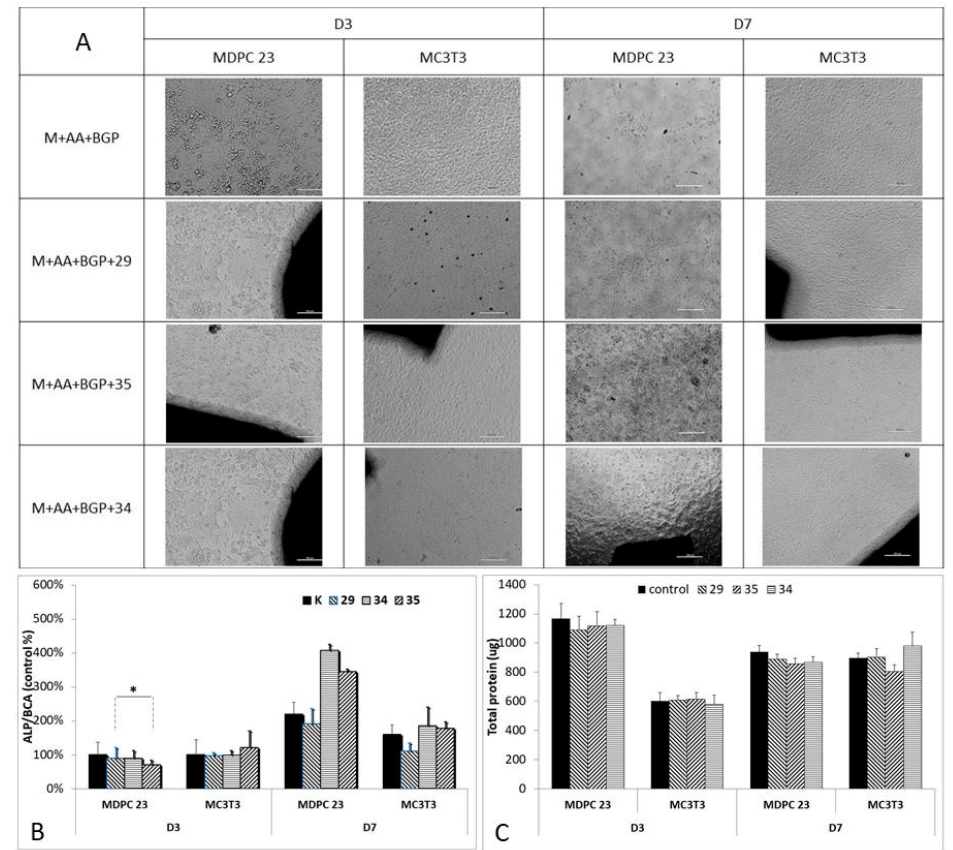
Figure 9. Morphology, alkaline phosphatase activity, and total protein content in MDPC23 and MC3T3-E1 cells after direct contact with PMC. ( A ) Light microscopy images of cells in direct con- tact with PMC, without visible cell death or excessive precipitation. ( B ) ALP/BCA values after 3 or 7 days. ( C ) Total protein content (BCA) of cells after 3 or 7 days. PMCs sample dimensions were 1.6 mm × 1.6 mm (cylinders), cured for 24 h before placing directly into wells with cells. M = medium, AA = ascorbic acid, BGP = β -glycerophosphate. * indicate p < 0.01, and 0.05, re- spectively, for comparisons made between formulation groups compared to the control, at each time point (Games −